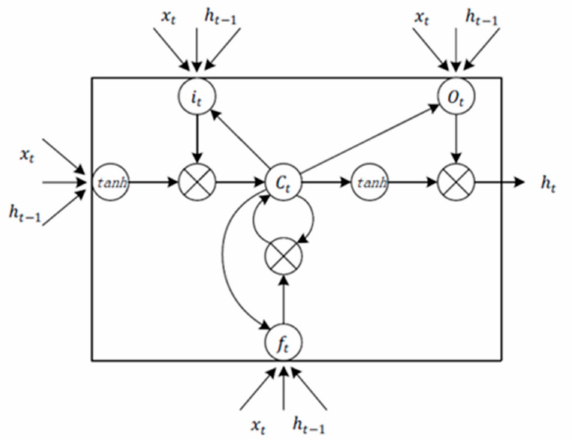
Figure 2. Structure of